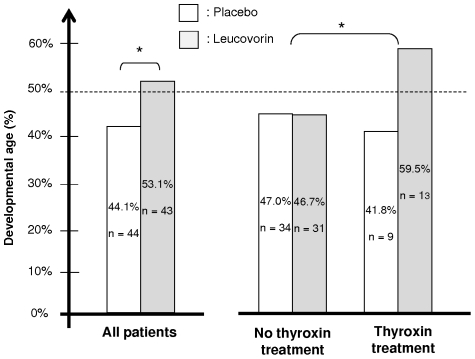
Effect of leucovorin treatment on change in global developmental age (DA).DA was measured for the patients receiving placebo or LV, in the per protocol population (87 patients) and as a function of a thyroxin treatment (N = number of patients, % change in developmental age with respect to a non-DS age-matched population).